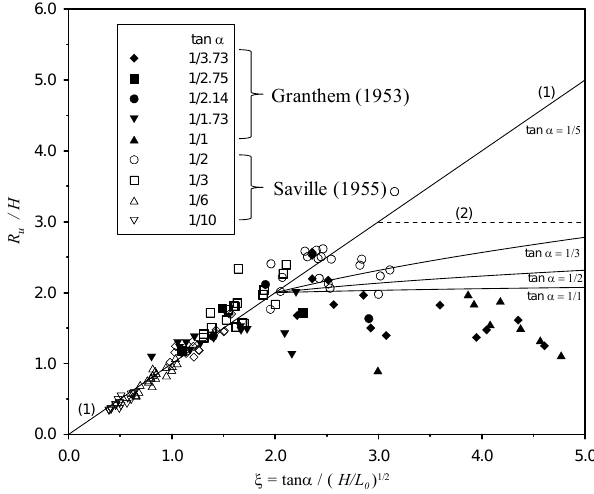
Fig. 8. Correlation and confidence interval between numerical Figure 8. Correlation and confidence interval between numerical model ( R u /H ) and empirical 2 model ( R u /H) and empirical formula (Eq. 9). formula (Eq. (10)). 3